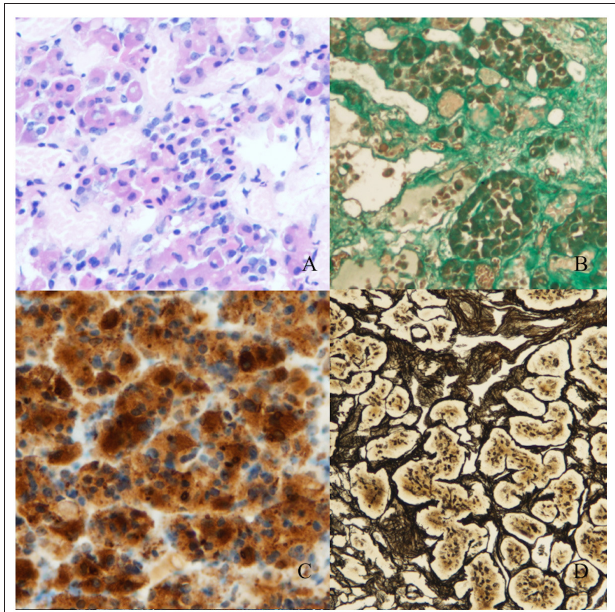
FIGURE 4 | Histopathological material (magnification 100x, Olympus DP73). (A) Stained with hematoxylin and eosin. (B) Masson’s trichrome staining for connective tissue. Numerous gland cell nests are visible between the fibres of connective tissue of the Rathke’s cleft cyst. (C) Staining for ACTH. Numerous groups of ACTH + cells are visible in the Rathke’s cleft cyst’s wall. (D) Reticulin staining shows a regular fiber pattern with numerous cell nests suggesting non-adenomatous cell